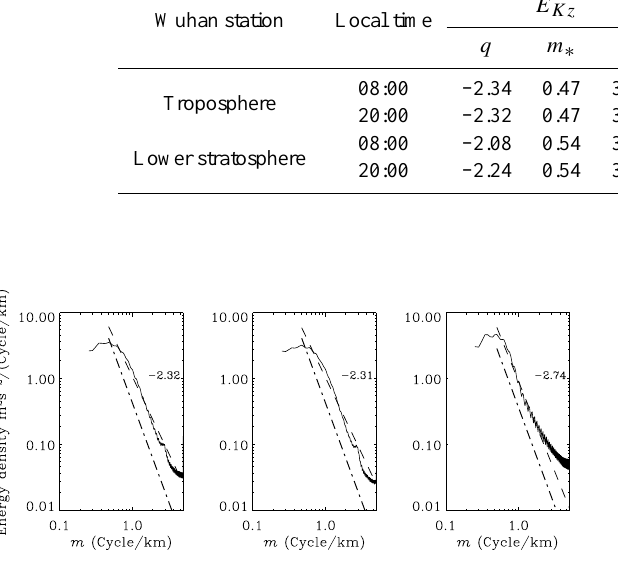
Fig. 2. Averaged vertical wave number spectra (solid curves) for the zonal kinetic energy density (left panel), meridional kinetic energy density (middle panel) and potential energy density (right panel) in the troposphere over Wuhan station, the dashed lines denote the fitted spectra. The theoretical saturation limits of Smith et al. (1987) are also plotted for comparison purposes (dash-dotted lines).